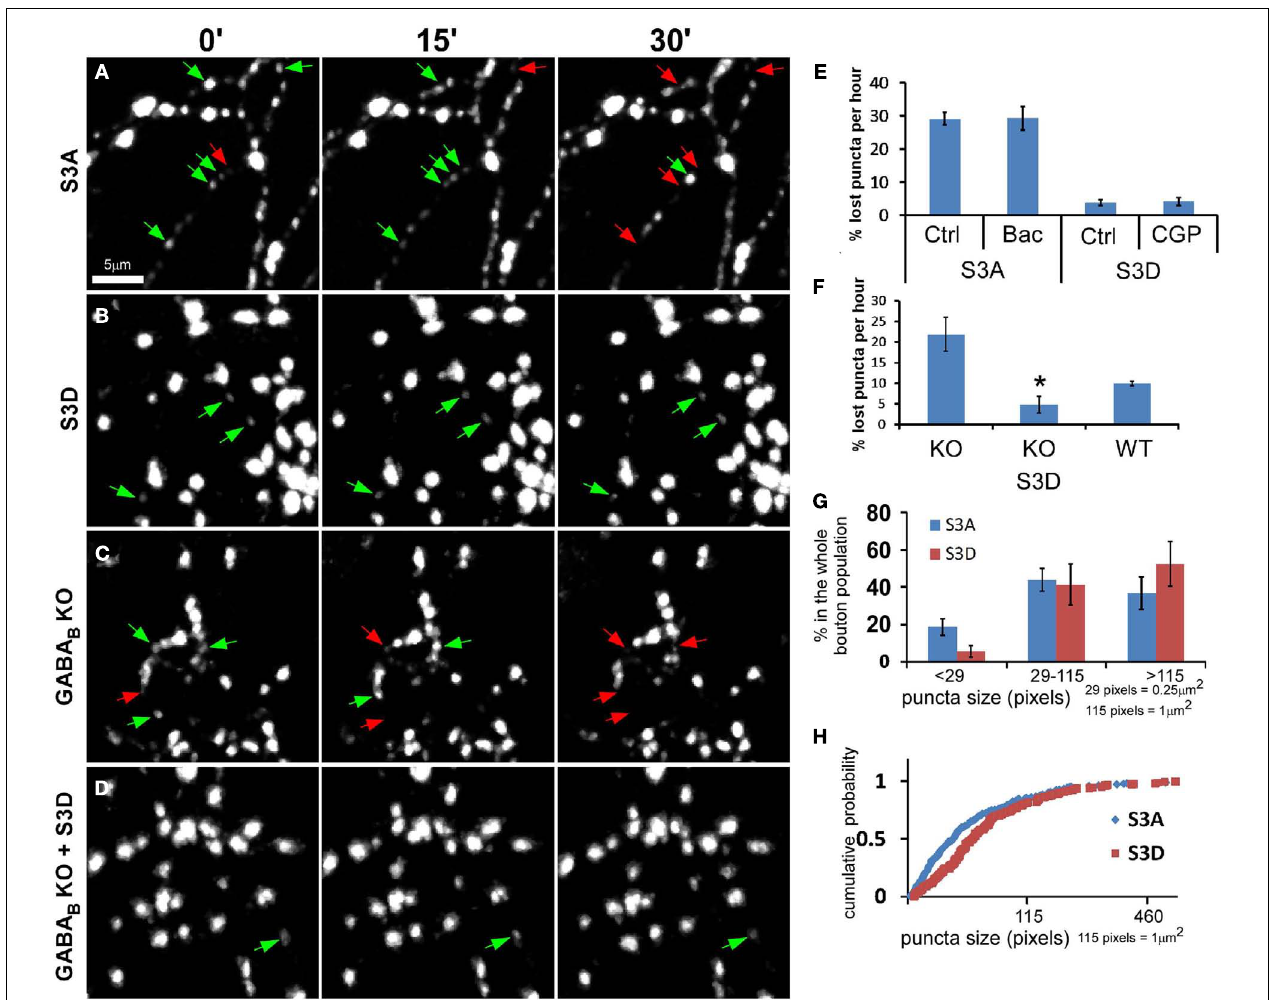
group). (F) Lost puncta in (C) and (D) , as well as that ofWT PV neurons from slice cultures from sibling GABA B1 + / + ::PV-ires-Cre mice were quantified.The value of KO andWT were re-plotting of Figure 5B ( n = 5 cells for each group; one-way ANOVA, post hoc Dunn’s test, P = 0.01 for KO vs. KO S3D). (G–H) Actin depolymerization resulted in increased population of small syn-GFP puncta. Cortical PV neurons were transfected with LSL-syn-GFP , as well as either LSL-cofilin(S3A)-mCherry or LSL-cofilin(S3D)-mCherry using slice cultures from PV-ires-Cre mice at EP15–17. Bouton size was analyzed at EP20. (G) The distribution of different size population of syn-GFP puncta of S3A and S3D transfected neurons ( n = 5). (H) Cumulative distribution of all puncta of S3A and S3D transfected neurons, showing significant divergence for puncta smaller than 1 µ m ( K - S test, P < 0.0001).